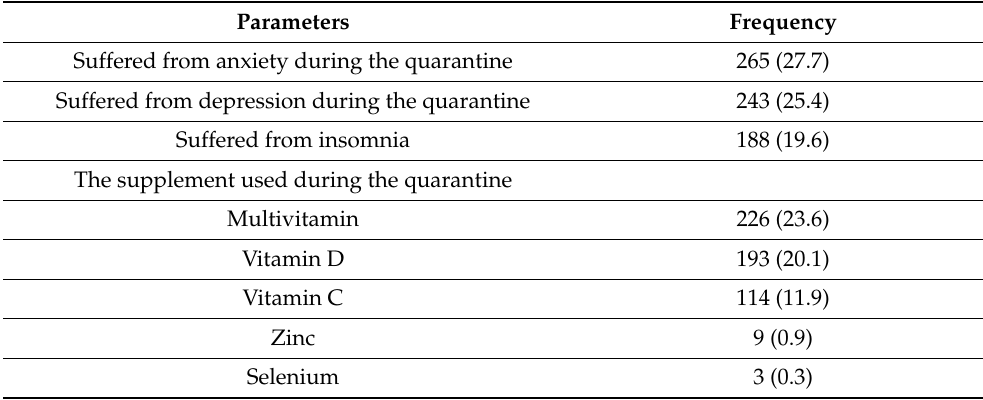
Table 2. Prevalence of micronutrient dietary supplements, depression, anxiety, and insomnia among the participants.